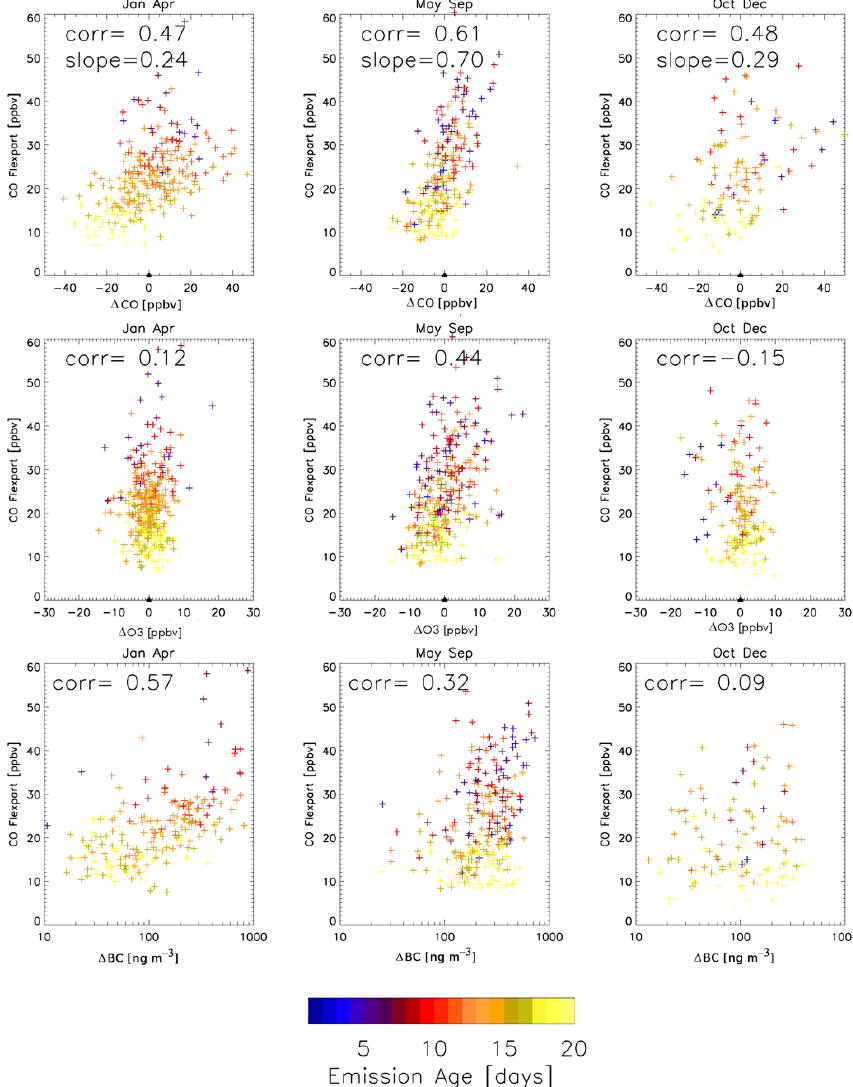
Fig. 9. Observed 1 CO (first row), 1 O 3 (second row) and BC (third row) versus FLEXPART CO ant for January–April (left column), May– September (middle column) and October–December (right column). Data are averaged over 24h and are tagged with emission age of CO ant (colored scale). The linear correlation coefficients ( corr ) is reported for all the scatter-plots while the slope values ( slope ) are only reported for the 1 CO-CO ant